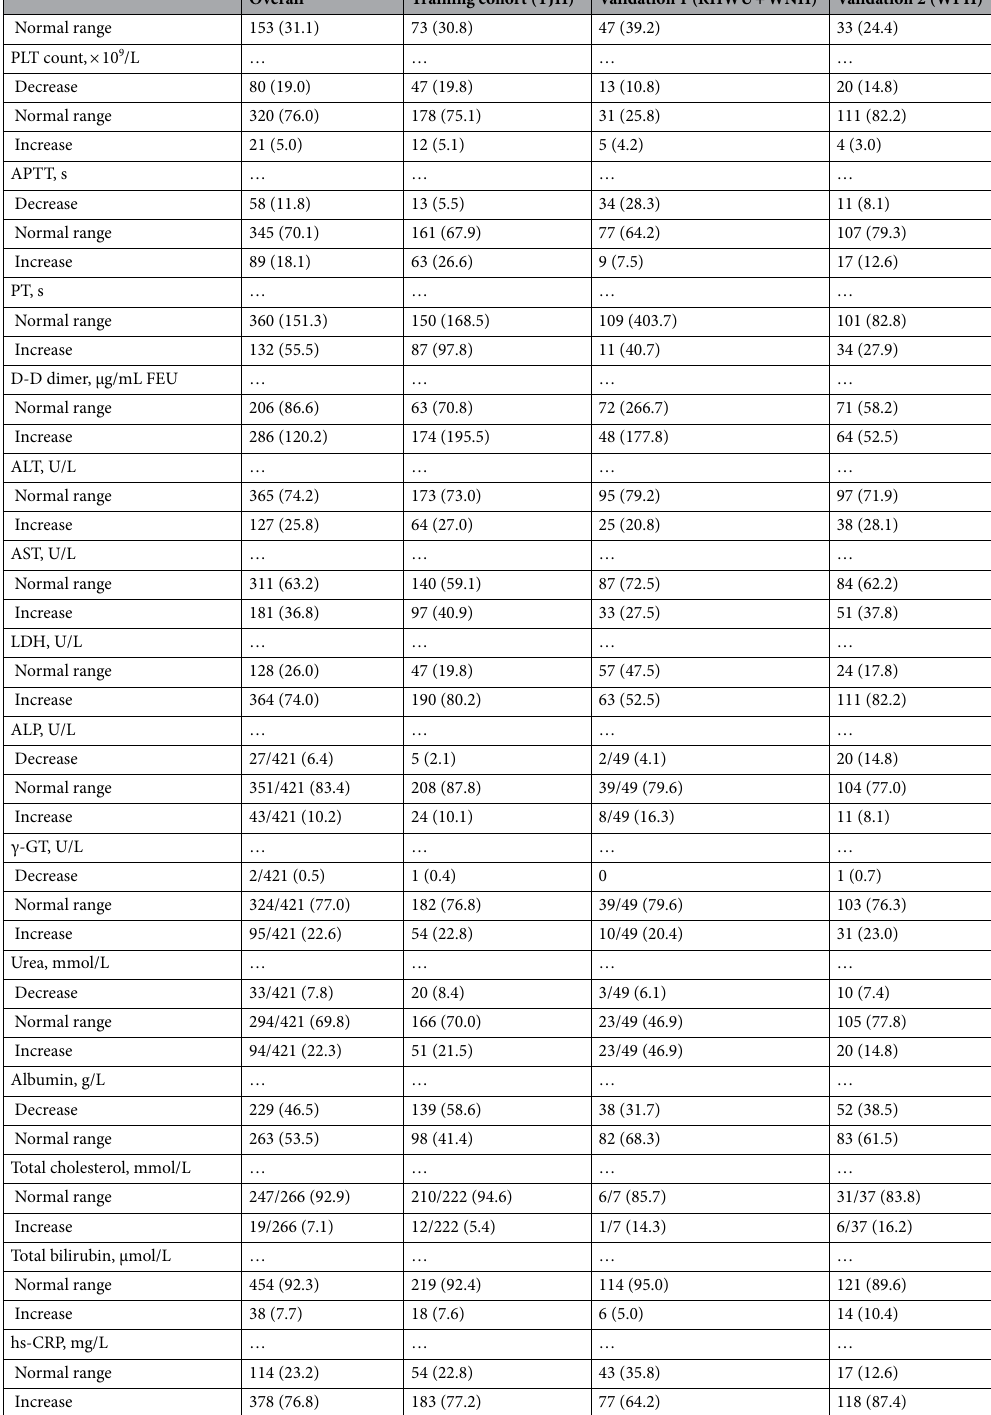
Table 1. Clinical characteristics, treatments and laboratory findings of the Training (TJH), Validation 1 (RHWU + WNH), and Validation 2 (WPH) cohorts. Data are median (IQR), n (%), or n/N (%), where N is